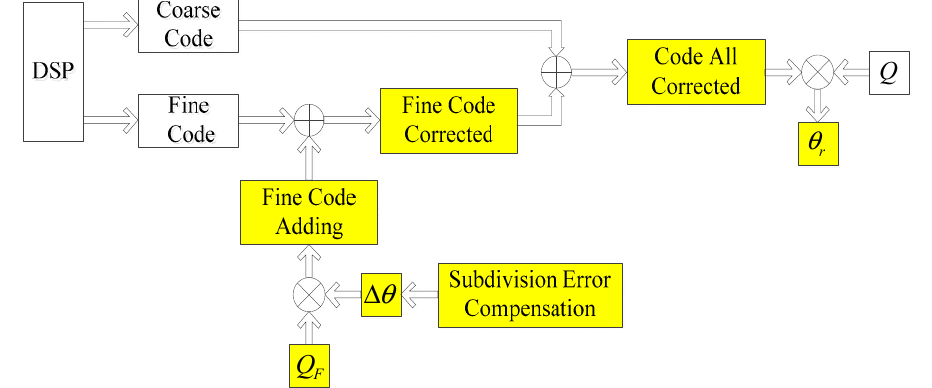
Figure 9. Compensation algorithm for the angle encoder.